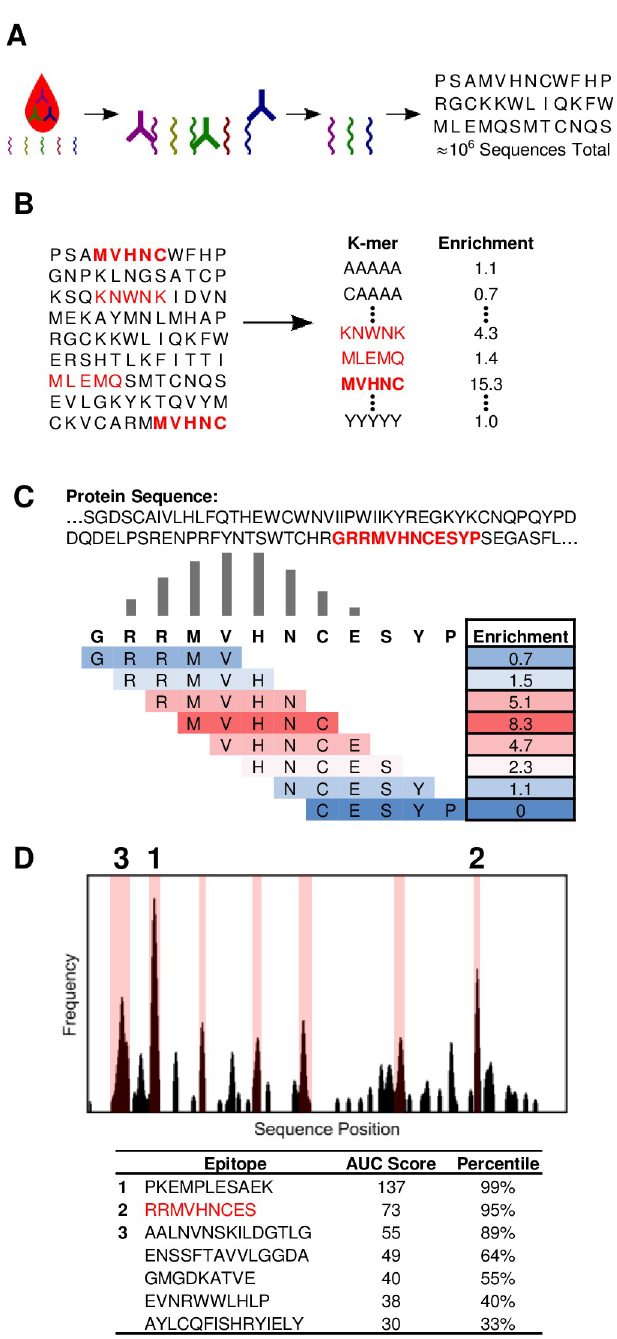
Fig 1. K-TOPE determines epitopes by tiling proteins into k-mers. (A) The input to the algorithm is a dataset of approximately 10 6 peptides that were bound by serum antibodies. (B) All 5-mers are evaluated for their enrichment in the list of peptides. (C) A portion of a protein sequence is tiled into 5-mers which are weighted by their enrichment. This determines a “frequency” value for each position in the sequence. (D) The frequency value for each position in a protein sequence is plotted as a histogram. Possible epitopes are highlighted in pink on the graph. Epitope sequences, area under the curve (AUC) scores, and significance percentiles are displayed.